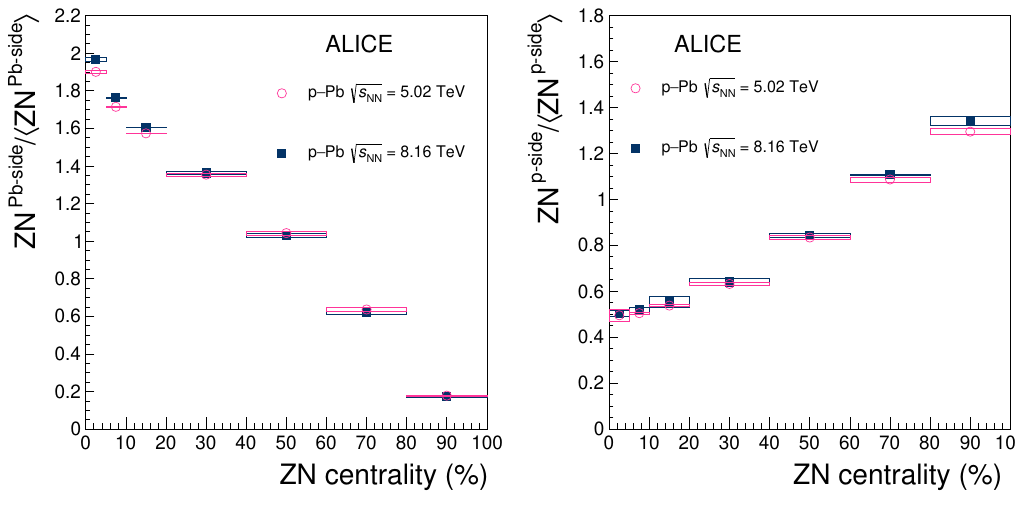
Figure 3 . ZN energy normalised to the average MB value in the Pb-fragmentation (left) and in the p-fragmentation (right) regions as a function of centrality estimated from ZN [17] in p-Pb collisions √ at s NN = 5 . 02 TeV (pink circles) and 8 . 16 TeV (blue squares). The boxes represent the systematic